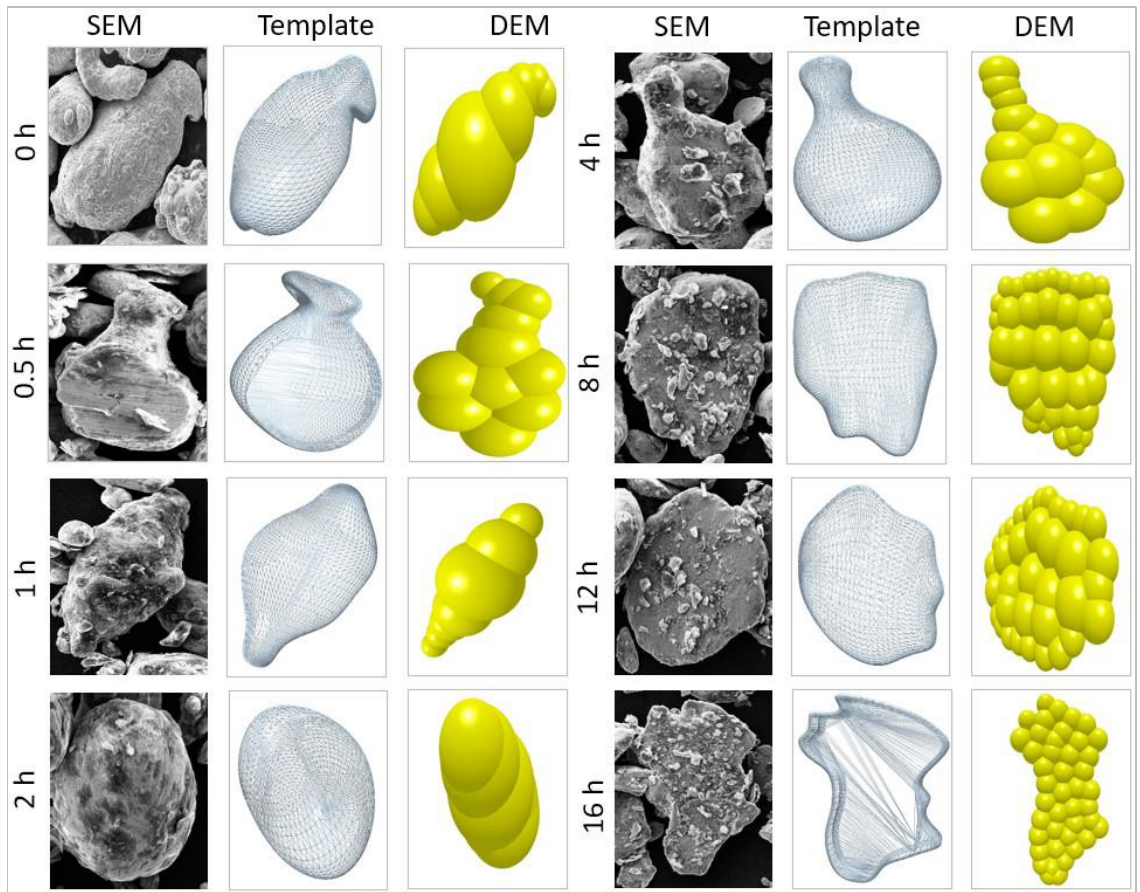
Figure 4. Examples of created 3D particles showing the morphological evolution of particle shape from spherical to flat with increasing milling time.